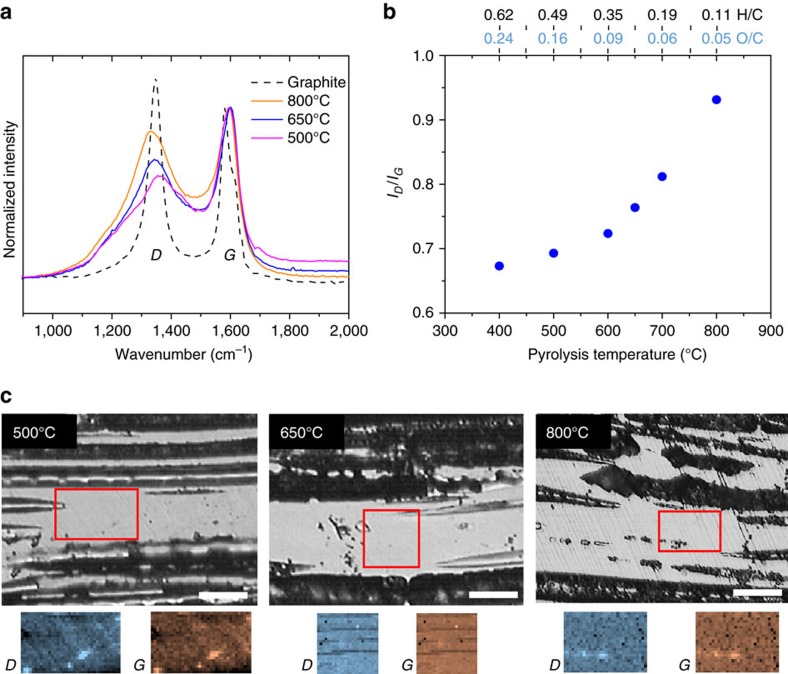
Raman spectral mapping.(a) Raman spectra of pyrogenic carbon matrices. Chart legend indicates pyrolysis temperature. Dashed line indicates the spectrum of commercial graphite from Sigma-Aldrich. Each spectrum is a sum of >600 single spectra taken over ∼25 × 25 μm areas of pyrogenic carbons and a graphite surface to provide representative spectra with high signal-to–noise ratio. (b) The ratio of D to G peak intensity at different pyrolysis temperatures. The intensity ratio was calculated based on peak heights obtained by fitting a Lorentzian curve to the D peak, and a Breit–Wigner–Fano curve to the G peak. The corresponding molar H/C and O/C ratios are given above the top x axes of b. (c) Optical microscopy images of finely polished sections of pyrogenic carbon at different pyrolysis temperatures. Raman spatial maps of D and G peak intensities were acquired from areas indicated on the optical image. Scale bars are 25 μm. Surface roughness of areas mapped are <2 μm.